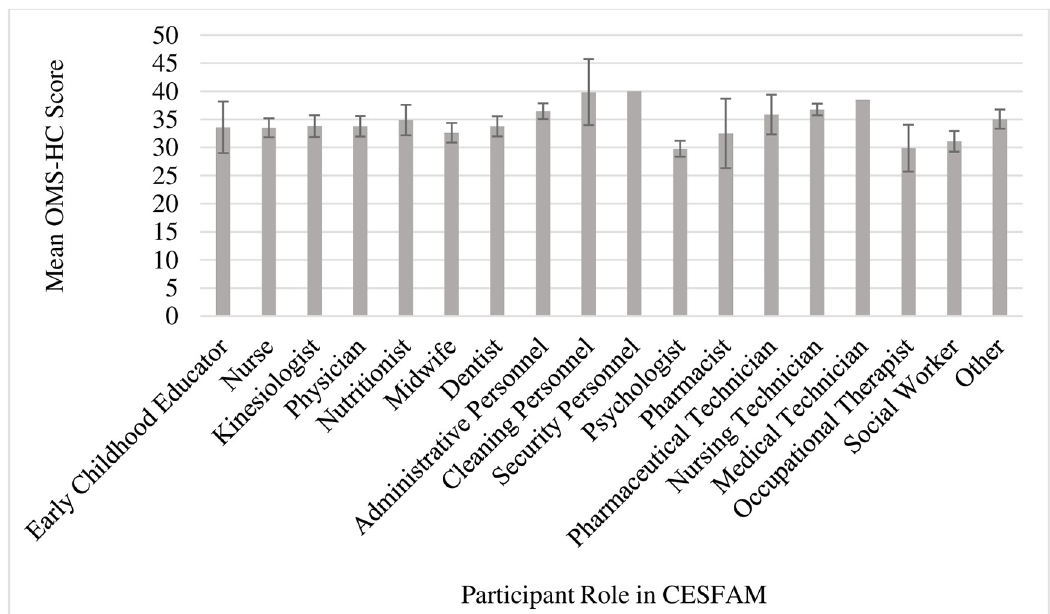
Fig 1. Mean Opening Minds Scale for Health Care Providers (OMS-HC) score by participant role in CESFAM. Note: CESFAM = Centro de Salud Familiar (Chilean Public Primary Health Care Clinic). Bars represent 95% Confidence Interval. Security Personnel and Nursing Technician do not have Confidence Intervals represented due to small sample